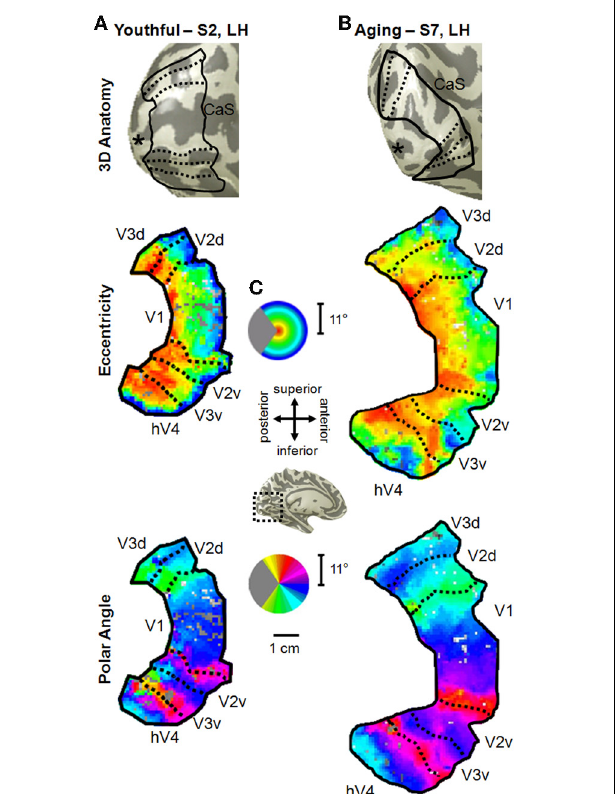
FIGURE 2 | Visual field map measurements in healthy young and aging subjects. (A) Example of VFMs V1, V2, V3, and hV4 from a healthy young adult (S2, left hemisphere). VFM boundaries are overlaid on a 3D representation of S2’s left hemisphere (top panel). The “ ∗ ” denotes the occipital pole. A cropped, close-up view of the flattened cortical surface surrounding the calcarine sulcus is shown for measurements of eccentricity and polar angle in the middle and bottom panels, respectively. The pseudo-color overlay on each flattened cortical rendering represents the position in visual space that produces the strongest response at each cortical location[seecoloredlegendinsetsin (C) ].Thestimulicoveredthecentral11 ◦ radius of visual space. For clarity, the visual responses are only shown for the VFMs of interest, V1, V2, V3, hV4. (B) Example of VFMs V1, V2, V3, and hV4 from a healthy aging subject (S7, left hemisphere). Note regular, organized, orthogonal VFMs as seen in (A) . (C) Legends and scale bar for flattened cortical maps are shown. Approximate cortical location is depicted on an example left hemisphere 3D rendering (black dotted lines, central